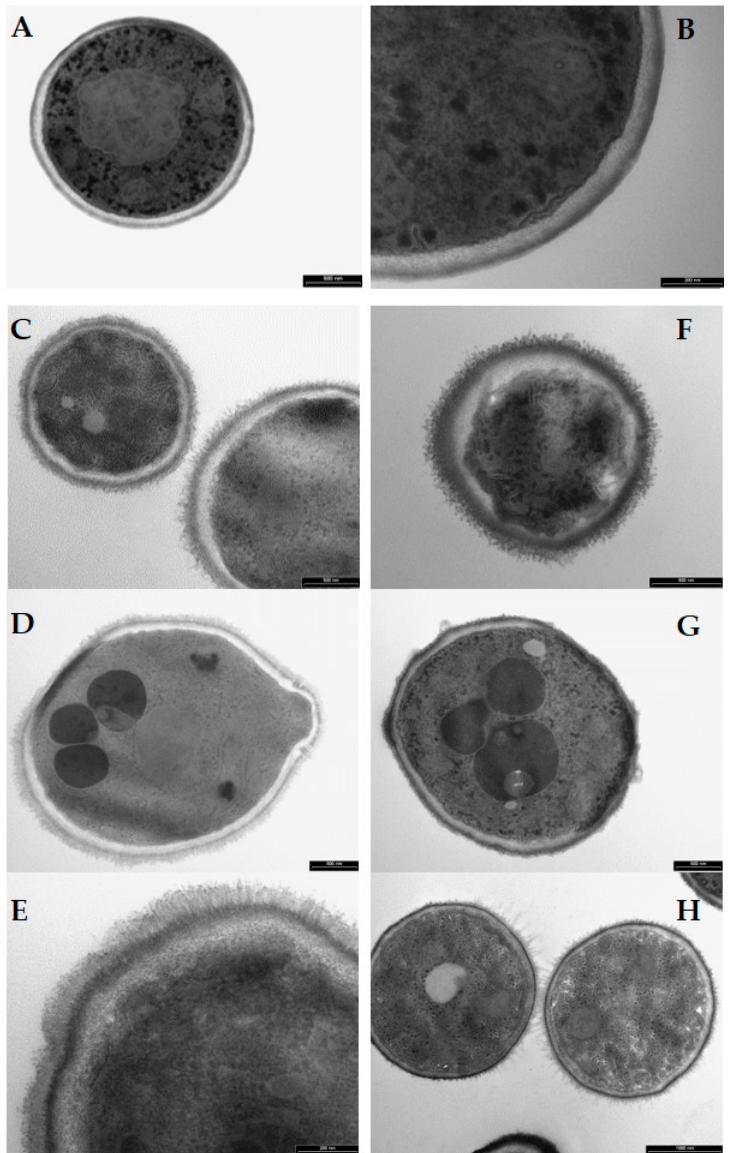
Figure 13. Transmission electron microscopy images of Candida albicans cells treated for 60 min with selected KP-derivatives. ( A , B ): untreated (control) cells. ( C – E ): H10S-treated cells. ( F – H ): K10S-treated cells. Yeast cells treated with H10S and K10S (250 µM) revealed structural and morphological alterations. Bars = 500 nm ( A , C , D , F , G ), 1000 nm ( H ), 200 nm ( B , E ).